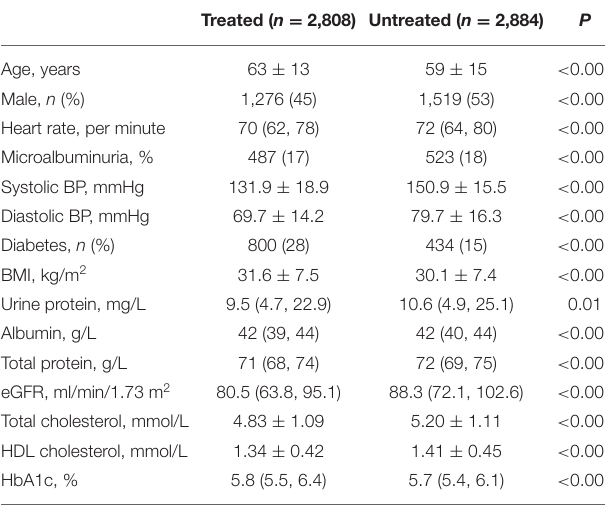
TABLE 2 | Characteristics of individuals with hypertension according to the usage of antihypertensive drugs. Treated ( n = 2,808) Untreated ( n = 2,884)